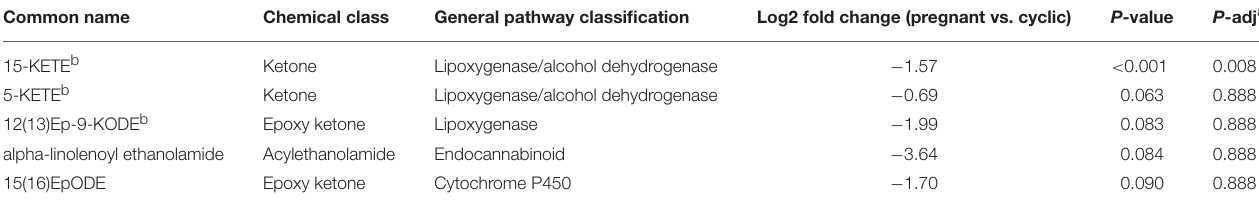
TABLE 2 | Differentially abundant lipids, and those that tended to be differentially abundant, in CL of day 18 of the estrous cycle and pregnancy.